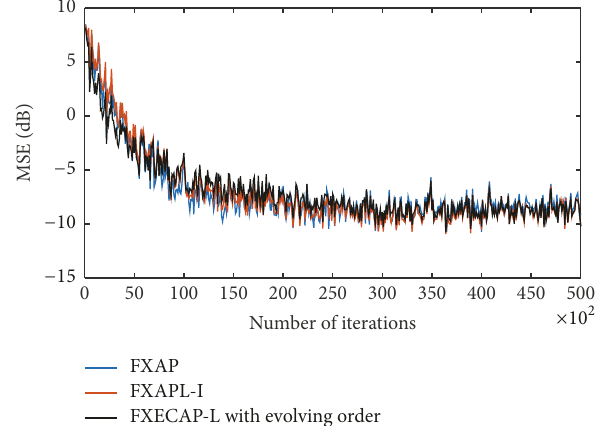
Figure 12: MSE values of the tested AP algorithms as measured at error sensor 1 for a projection order of 𝐿 = 5 when 𝑏 = 2 bits are used to encode the error.